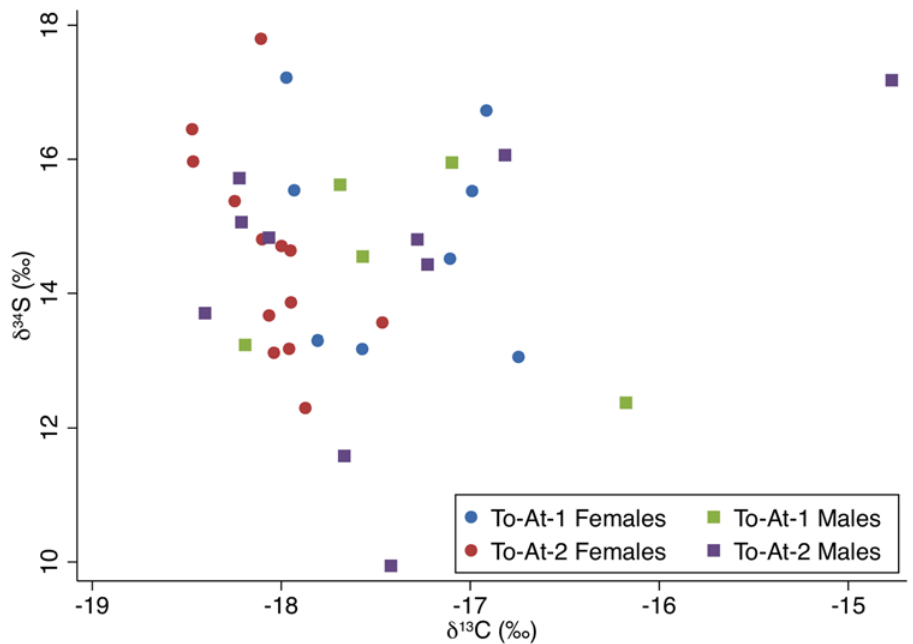
Fig 5. δ 13 C and δ 34 S values plotted by sex and burial mound. The δ 34 S outlier (To-At-2/27A) is labeled.